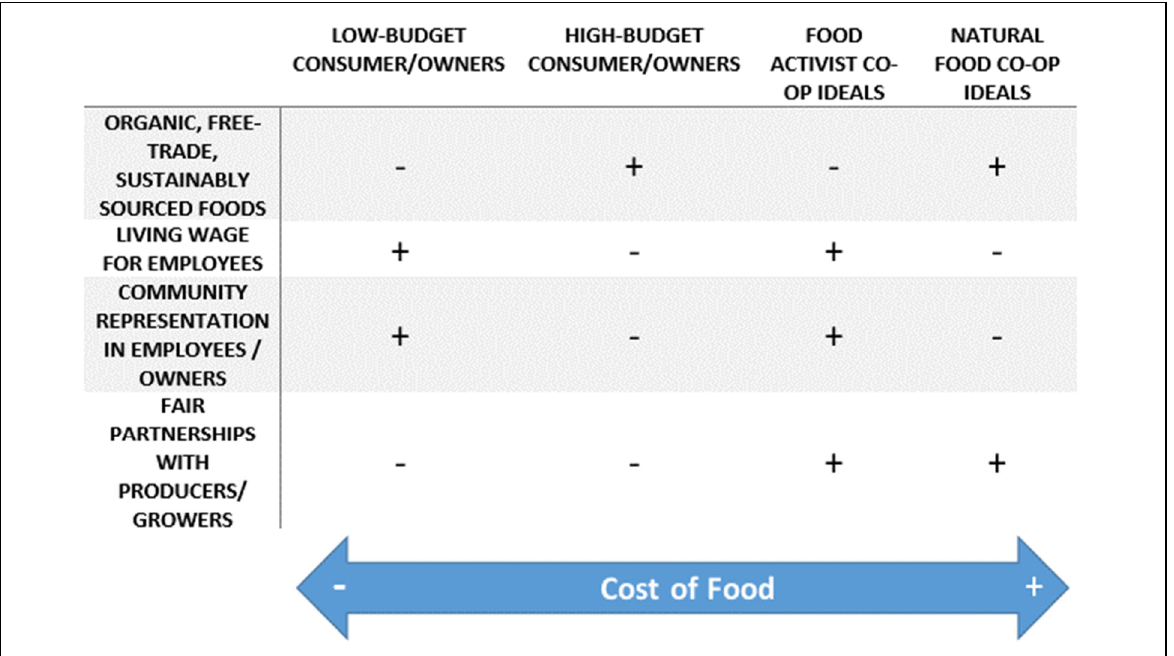
Figure 1. Finding Balance Among Shareholder Values and Food